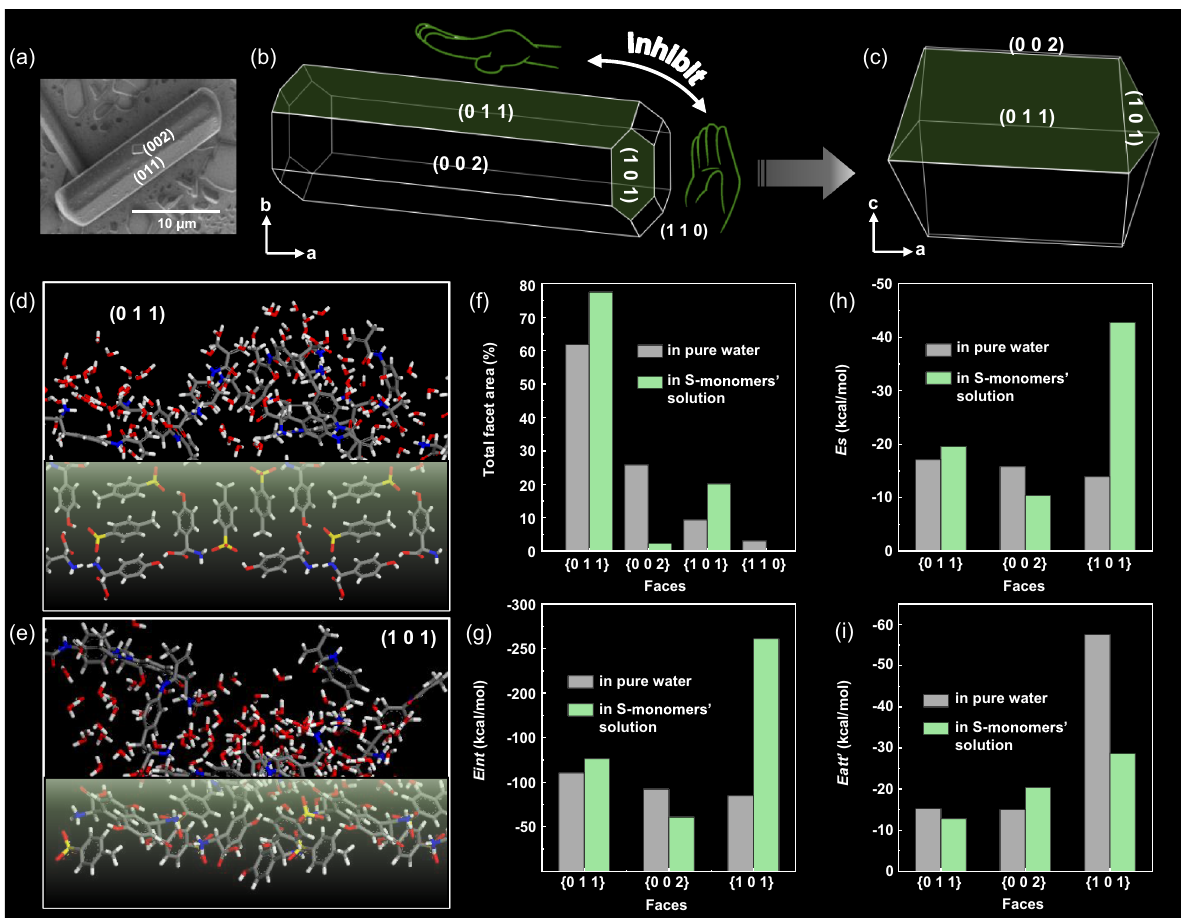
Fig. 5 Mechanism for morphological changes of D - p Hpg p Ts. a SEM image of a D - p Hpg p Ts single-crystal obtained from dilute aqueous solution by slow evaporation. b The simulated crystal habit of D - p Hpg p Ts in pure water, the green faces are more likely to be attached by additives. c The simulated crystal habit of D - p Hpg p Ts in 7.5 mol% L -monomer aqueous solution. d Surface structure of (0 1 1) face (green layer) with amino and carboxyl groups facing straight outward. After the molecular dynamics (MD) simulation, the molecules of H 2 O and L -monomers adsorbed on the surface. e Surface structure of (1 0 1) face (green layer) and the absorbed solution molecules after MD simulation. f The total facet area (%) of different faces in pure water and 7.5 mol% L - monomer ’ s aqueous solution. g E int of different faces in pure water and 7.5 mol% L -monomer ’ s aqueous solution. h Es of different faces in pure water